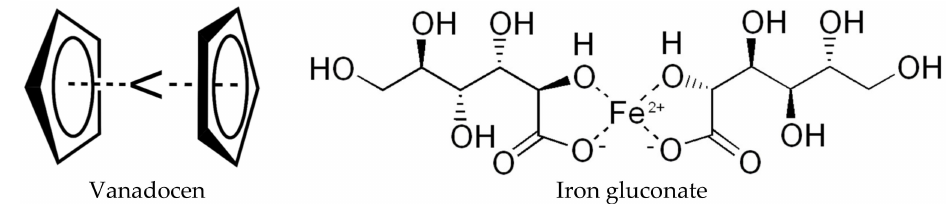
Figure 3. Chemical structure of two synthetic spermicide reagents, vanadocene and iron